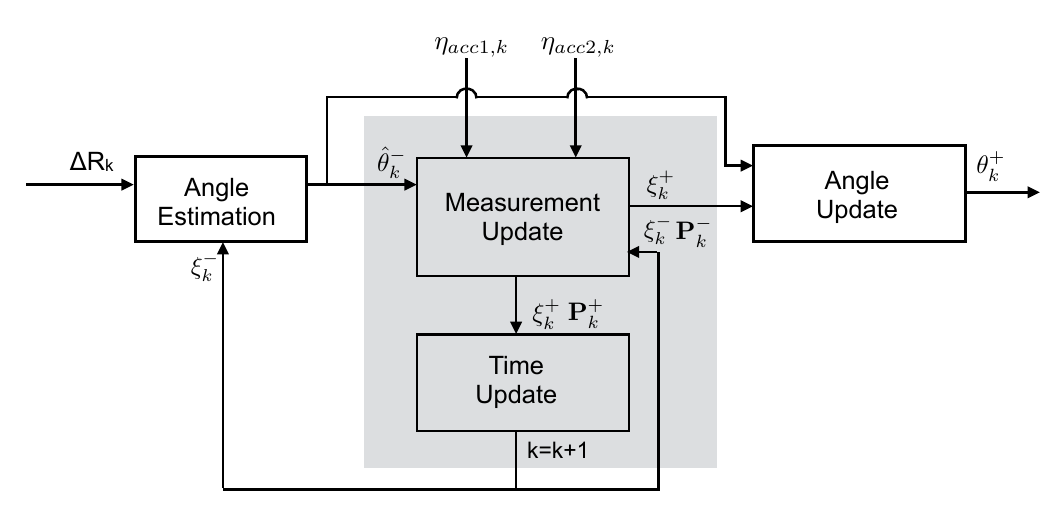
Figure 4. The goniometer/accelerometer fusion methods. The grey box represents the Kalman filter in its error state or indirect